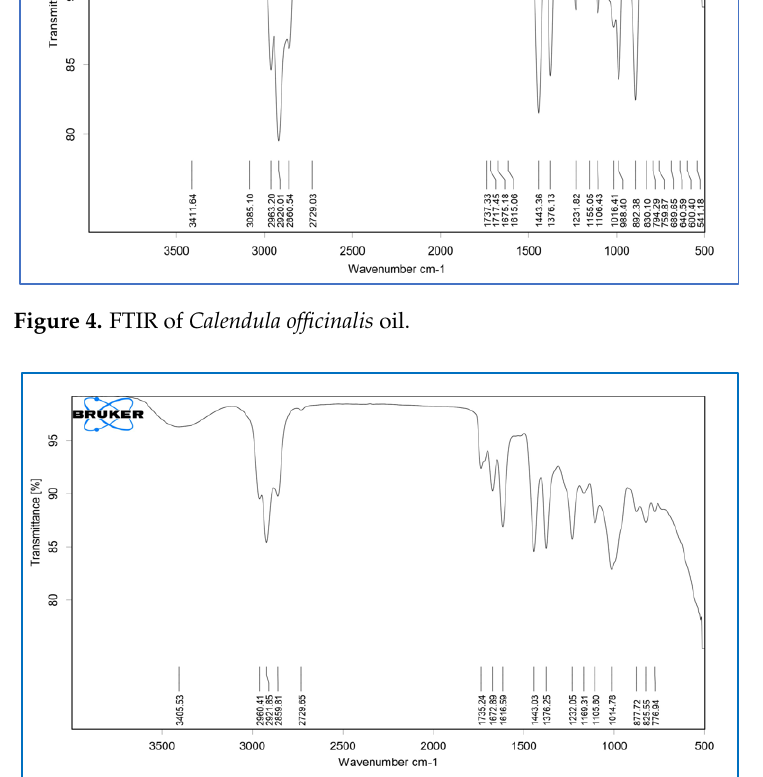
Figure 5. FTIR of Calendula officinalis oil-loaded gelatin sponge.